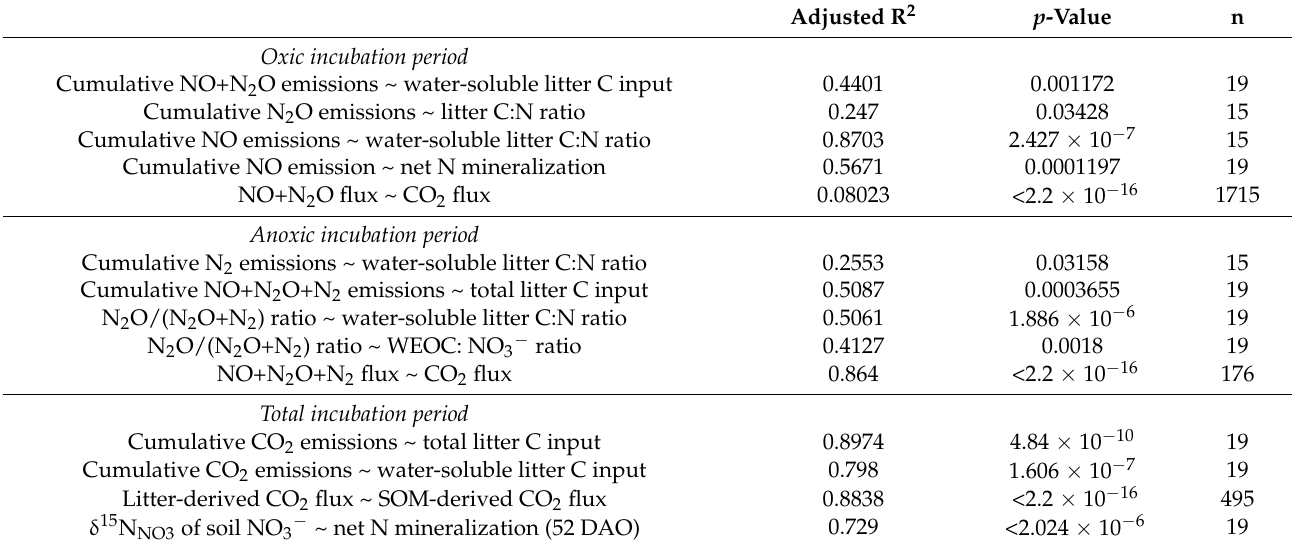
Table 3. Coefficients of determination and p -values for simple linear